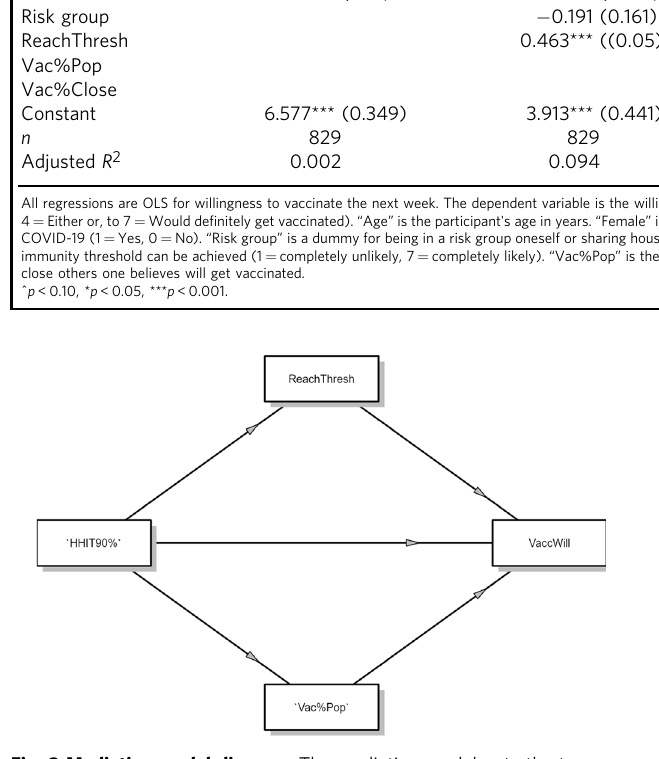
Fig. 2 Mediation model diagram. The mediation model puts the two beliefs, that the herd immunity threshold can be reached (ReachThresh) and that others in the population will get vaccinated (Vac%Pop), as mediators between the high herd immunity threshold condition and vaccine